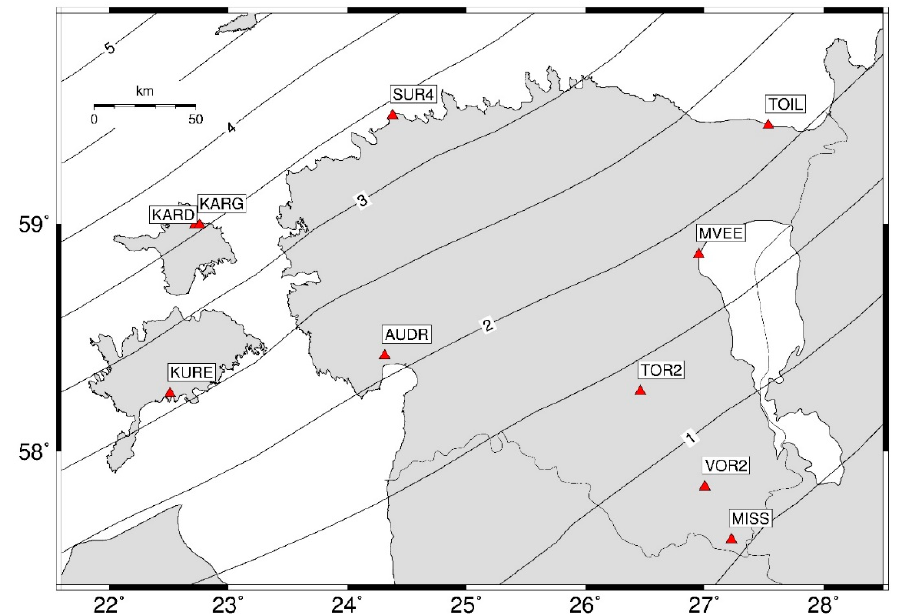
Figure 1. Location of Estonian continuously operating Global Navigation Satellite System cGNSS stations selected for this study (red triangles). In the background, contour lines of the absolute land uplift velocities (in mm/yr) according to the model NKG2016LU are presented.